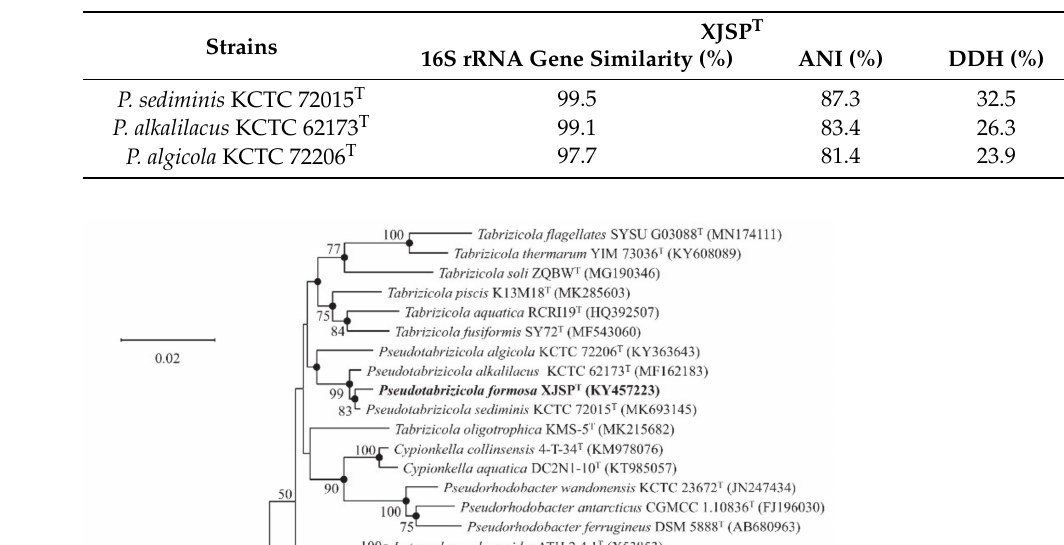
Table 1. Comparisons of the 16S rRNA gene sequence similarity, average nucleotide identity (ANI), and DNA–DNA hybridization (DDH) values between strain XJSP T and members of the genus Pseudotabrizicola .